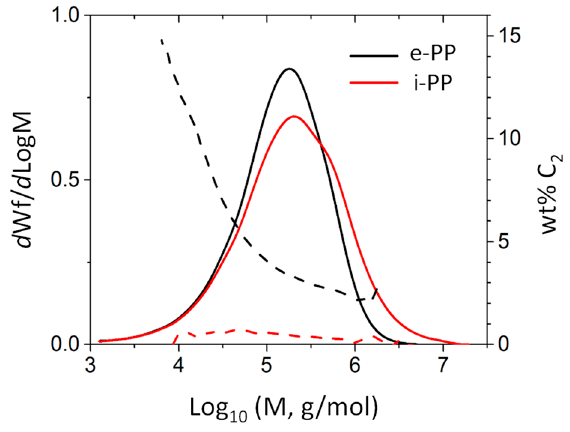
Figure 7. Gel permeation chromatograph (GPC) analysis result for e-PP and isotactic PP (i-PP).